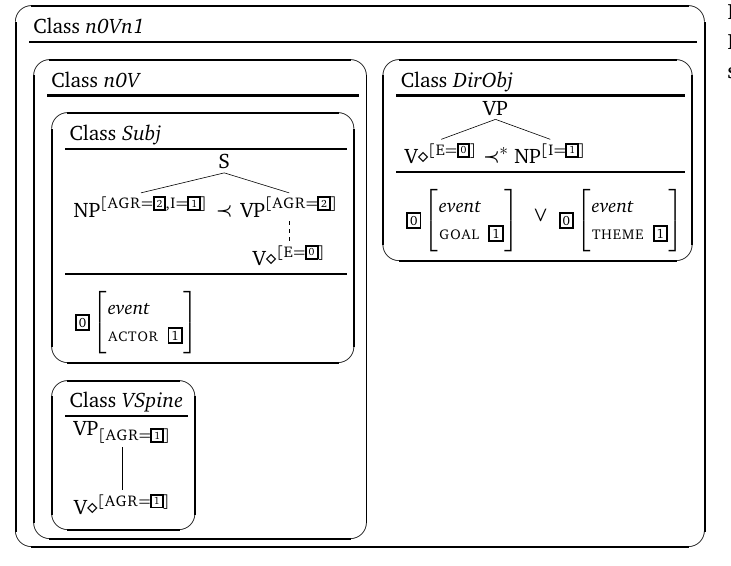
MG classes with semantic